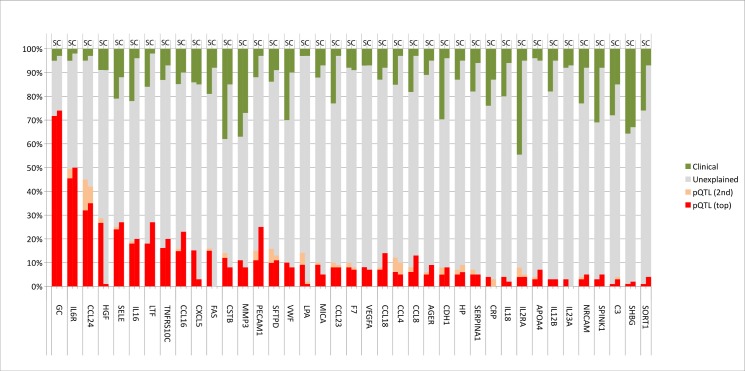
Blood biomarker variance explained by top two pQTLs SNPs and clinical covariates.The percent variation for 39 blood biomarkers explained by clinical (green) top pQTL SNP (red), second top independent pQTL SNP (peach), other unknown factors (grey). Clinical factors include age, gender, body mass index, smoking status, and principal components of ancestral genetic markers as described in the methods. The analysis includes subjects from SPIROMICS (S) and COPDGene (C) cohorts. TNRF (TNF-Related Apoptosis-Inducing Ligand Receptor 3 (TRAIL-R3)); PCAM (Platelet endothelial cell adhesion molecule (PECAM-1)); SRP1 (Alpha-1-Antitrypsin (alpha-1 (AAT)); NRC (Neuronal Cell Adhesion Molecule (Nr-CAM)); SPK (Pancreatic secretory trypsin inhibitor (TATI)); SRT1 (Sortilin); other abbreviations are listed in Table 1 and S2 Table.